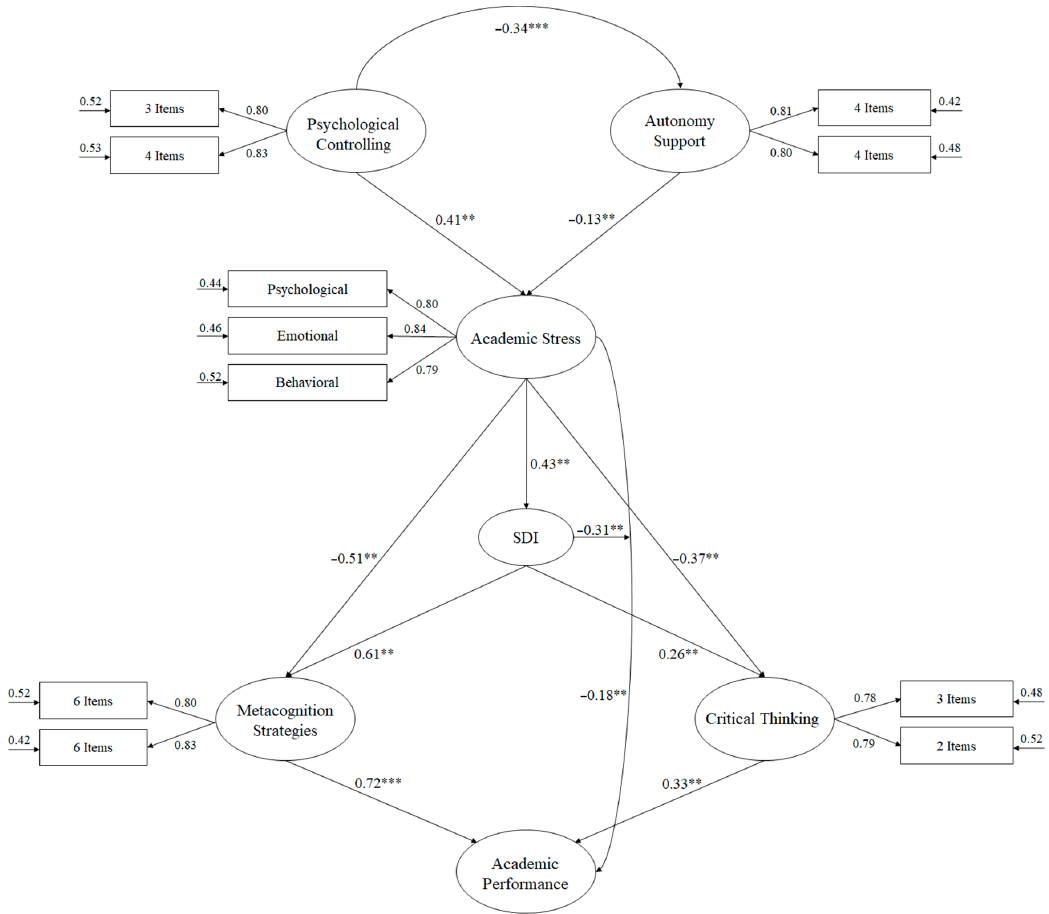
Figure 1. Structural equation model where the causal relationships between the variables of the study are established. Note: *** p < 0.001; ** p < 0.01. Self-Determination Index